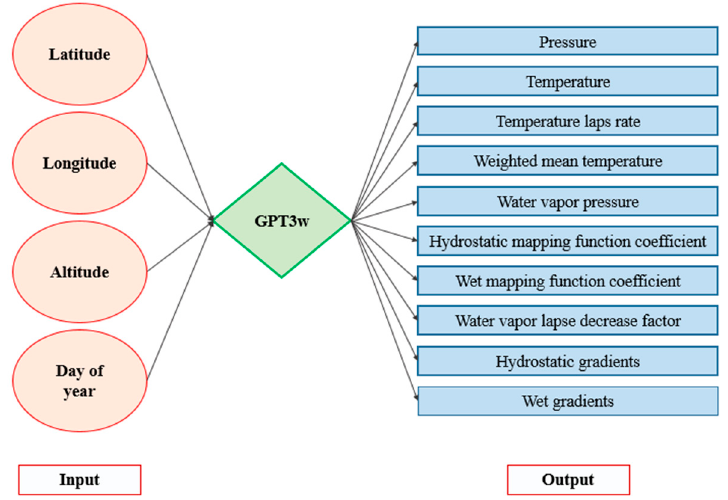
Figure 1. The input and output parameters for GPT3w model.